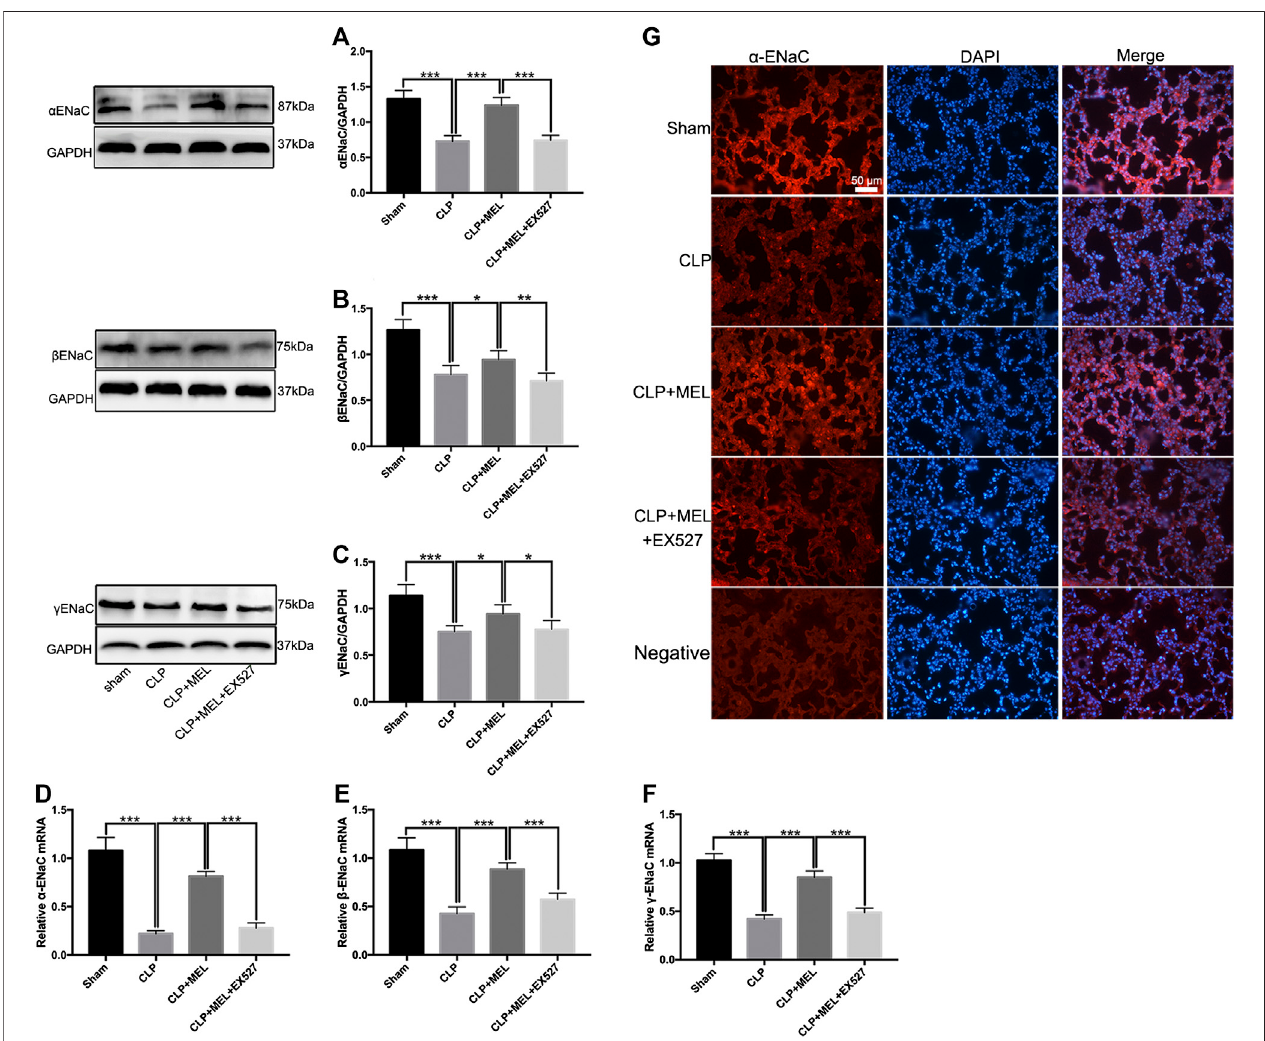
FIGURE 4 | Melatonin enhanced ENaC expression in CLP-induced ALI. The protein expressions of α -ENaC (A) , β -ENaC (B) and γ -ENaC (C) in ALI mouse were determinedbywesternblotusingGAPDHasaloadingcontrol.ResultsobtainedbydensitometryratiosoftargetproteinstoGAPDH.ThemRNAexpressionsof α -ENaC (D) , β -ENaC (E) and γ -ENaC (F) in ALI mouse were tested by real-time PCR. Gene expression was normalized with GAPDH as the housekeeping gene, and the relative expression of genes was calculated using the 2 − △△ Ct method. (G) The distribution and protein expression of α -ENaC was examined by immuno fl uorescence. All values are means ± SD ( n (cid:1) 6). *** p < 0.001; ** p < 0.01; * p < 0.05 (one-way ANOVA followed by Turkey post hoc